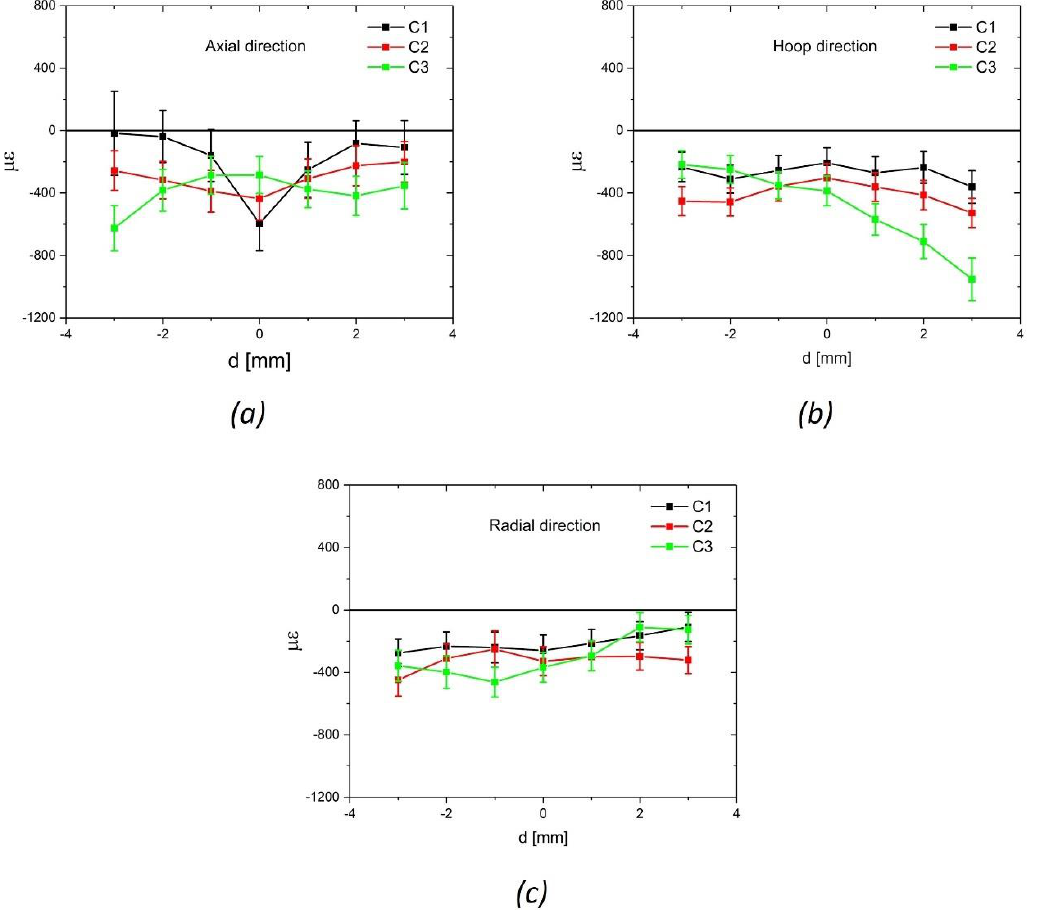
Figure 2. Residual strain distribution in the axial ( a ), hoop ( b ), and radial ( c ) direction of the samples after the first, second, and third C-ECAP pass.